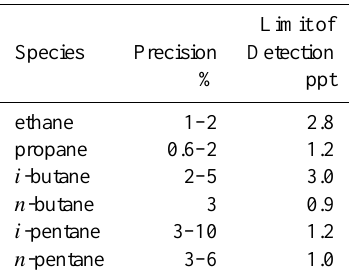
Table 1. Measurement parameters of sample precision and limit of